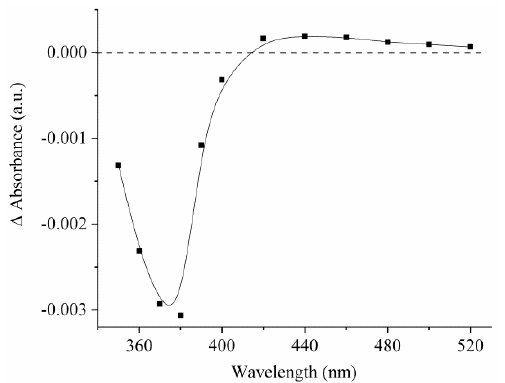
Figure 6. Photoinduced absorption spectrum of compound 2 measured at 5 µ s after the laser pulse. The concentration of compound 2 was 5 × 10 − 5 mol/L.